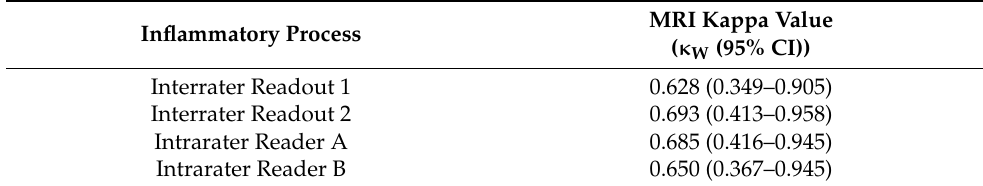
cesses is listed.